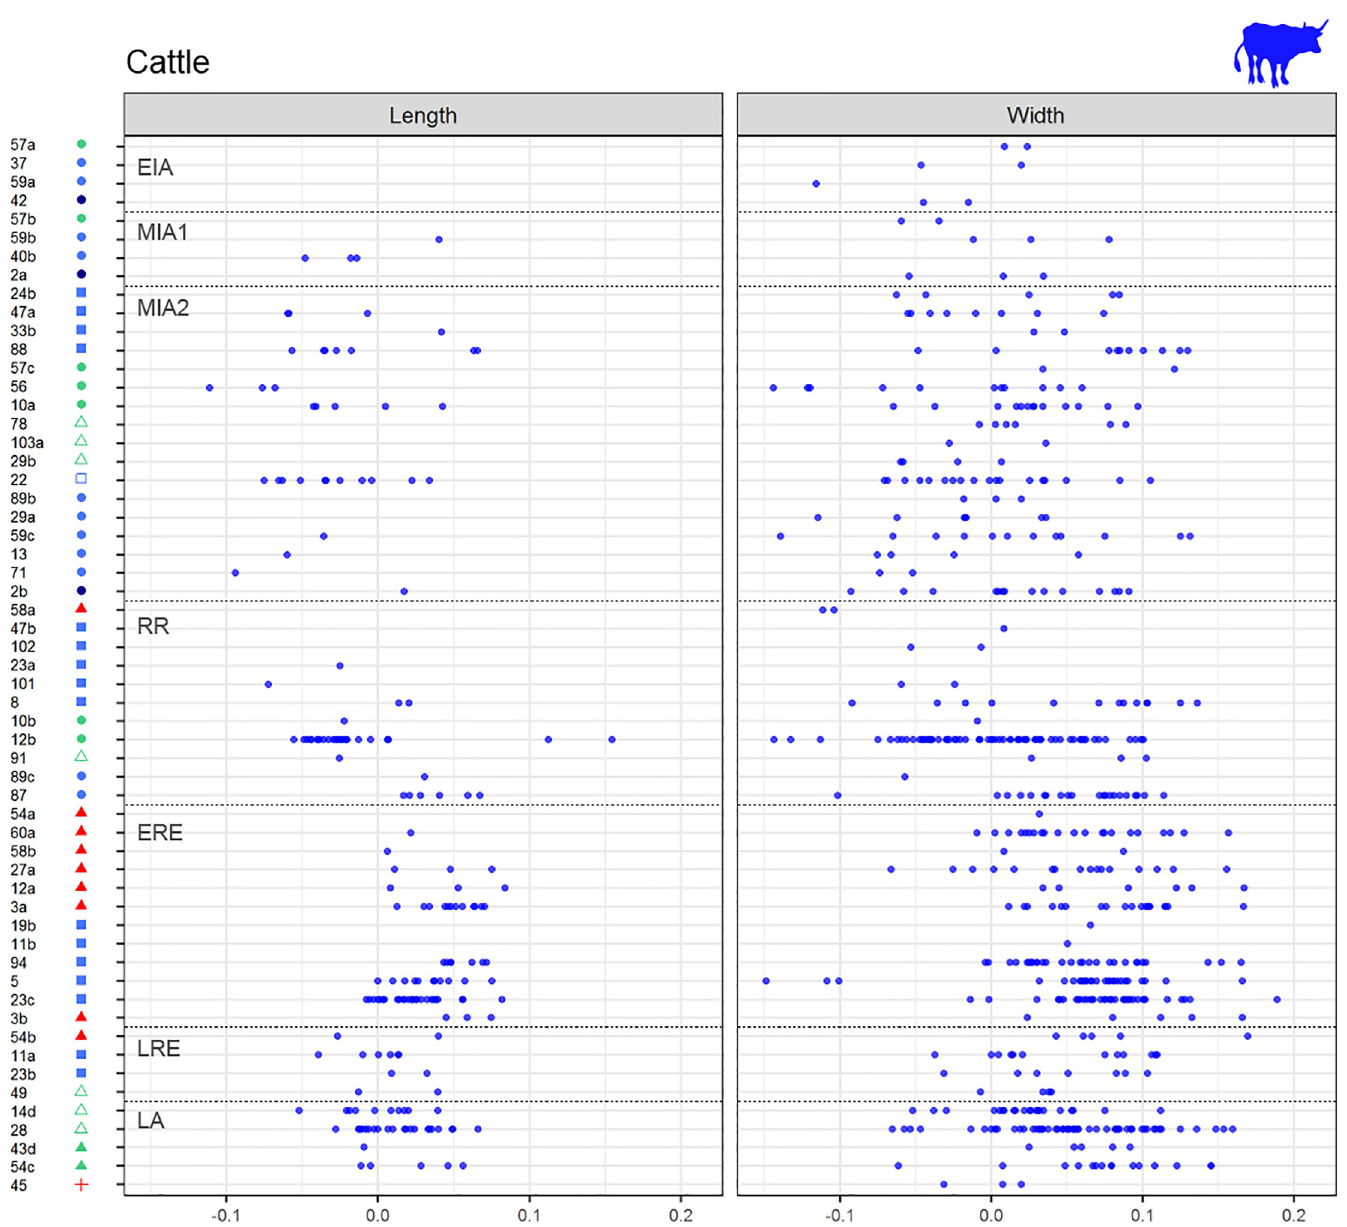
Fig 9. Cattle LSI length and width values by assemblages ordered by periods. (from top to bottom, EIA: Early Iron Age, MIA1: Middle Iron Age 1, MIA2: Middle Iron Age 2, RR: Roman Republic, ERE: Early Roman Empire, LRE: Late Roman Empire, LA: Late Antiquity). Left column shows length LSI values, right column shows width LSI values. Assemblages’ symbols refer to their type (see Fig